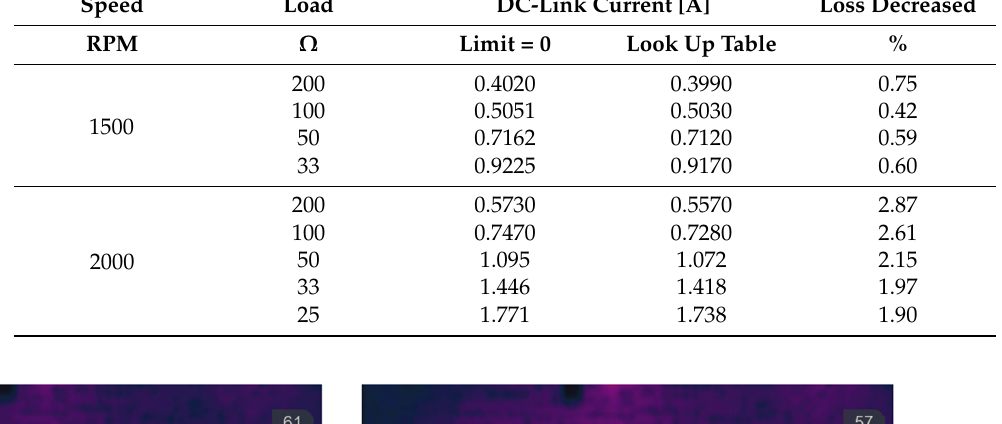
Table 2. DC-link current measurement.